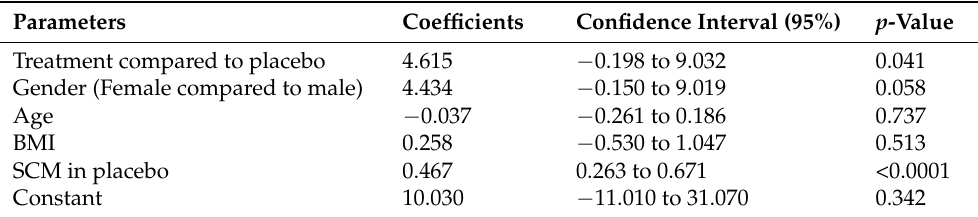
Table 7. Linear regression analysis of changes in the stratum corneum moisture (SCM) after 4 weeks of